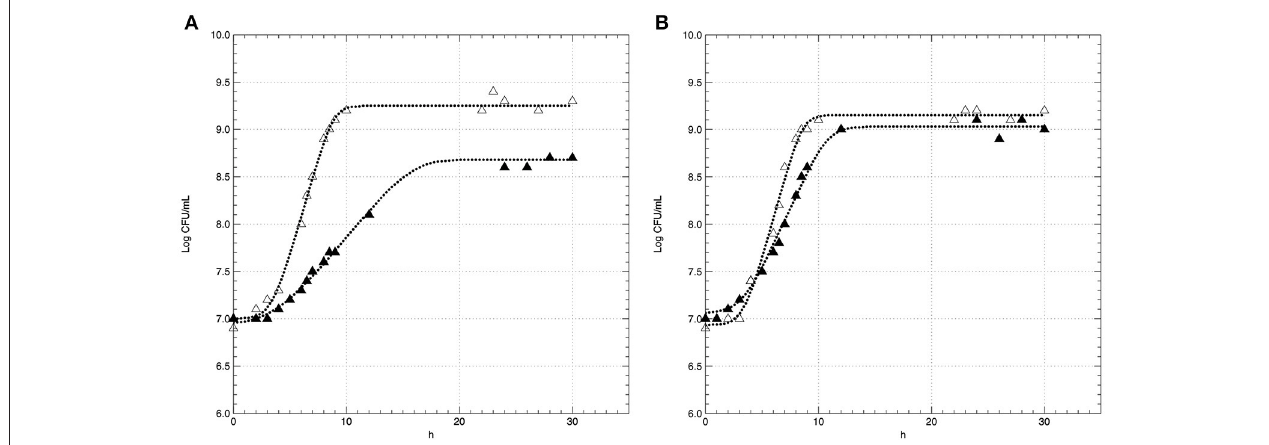
FIGURE 2 | Growth curves of L. innocua ATCC 33090 cultivated in conventional ( 1 ) and in acid stress ( N ) conditions after non-pre-acid-adaptation (A) or pre-acid-adaptation (B) . Symbols represents the experimental data, dotted curves represents the D-model.